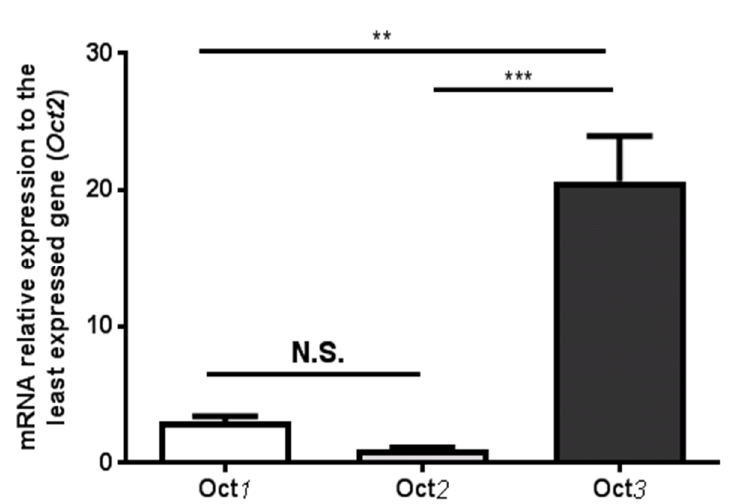
Figure 2. Relative expression of Oct1 , Oct2 and Oct3 mRNAs in brain cortical microvessels of Sprague-Dawley rats. Relative expressions were calculated using the 2 − ∆∆ CT method. ∆∆ CT values were obtained by subtracting ∆ CT values of each target gene from that of the least expressed gene ( Oct2 ) in a given sample, being ∆ CT the relative mRNA level of the target gene normalized to that of β -actin . Data are presented as mean ± S.D (n = 3, performed in duplicate). One-way ANOVA with Tukey’s multiple comparisons test (NS: no statistical significance, ** p < 0.01, *** p < 0.001).